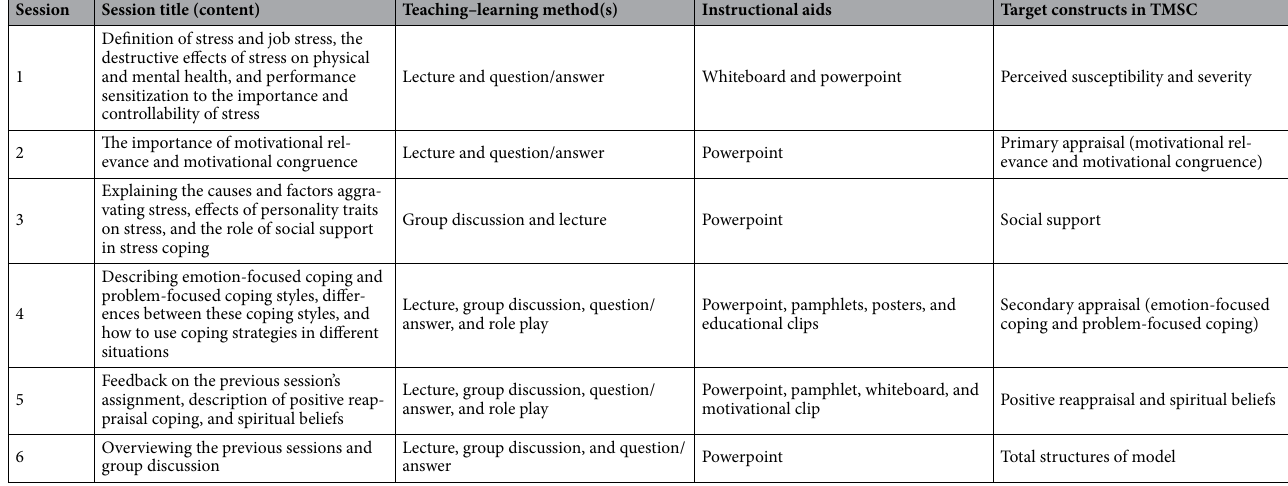
Table 1. Content of educational session.